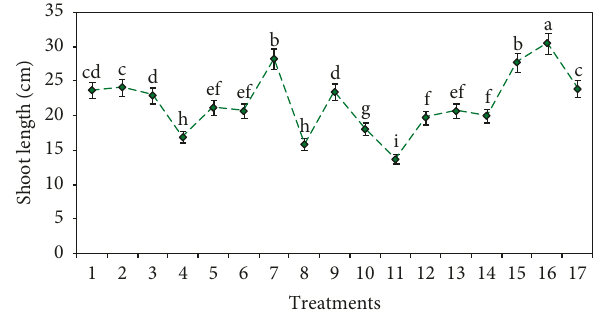
Figure 4: Impact of biosorbed water by various biosorbents (or- ange peels, pomegranate peels, and peanut peels) on the shoot length of mung bean after 7 days of seed germination. T1, negative control; T2, 50mg kg − 1 ; T3, pomegranate peel biosorbed water +50mg kg − 1 ; T4, peanut peel biosorbed water +50mg kg − 1 ; T5, orange peel biosorbed water +50mg kg − 1 ; T6, 100mg kg − 1 ; T7, pomegranate peel biosorbed water +100 mg kg − 1 ; T8, peanut peel biosorbed water +100mg kg − 1 ; T9, orange peel biosorbed water +100 mg kg − 1 ; T10, 150mg kg − 1 ; T11, pomegranate peel biosorbed water +150 mg kg − 1 ; T12, peanut peel biosorbed water +150 mg kg − 1 ; T13, orange peel biosorbed water +150 mg kg − 1 ; T14, 200mg kg − 1 ; T15, pomegranate peel biosorbed water +200mg kg − 1 ; T16, peanut peel biosorbed water +200 mg kg − 1 ; T17, orange peel biosorbed water +200mg kg − 1 . Vertical bars (I): standard error (mean of 3 replicates). Alphabets on vertical bars: significant difference ( P ≤ 0 . 05) evaluated by the LSD test.